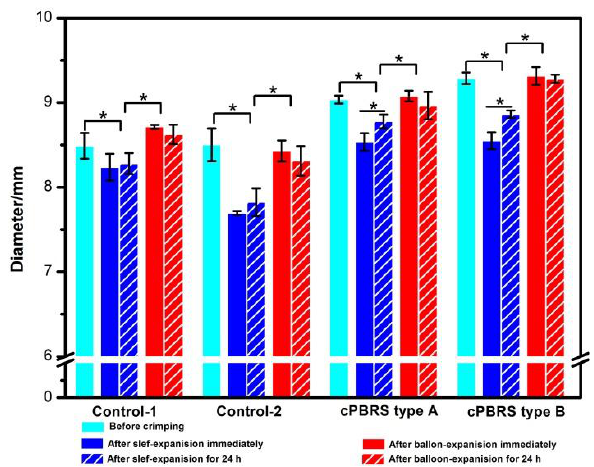
Figure 4. Diameter changes of different prototypes during crimping and expanding process. (* means p < 0.05)